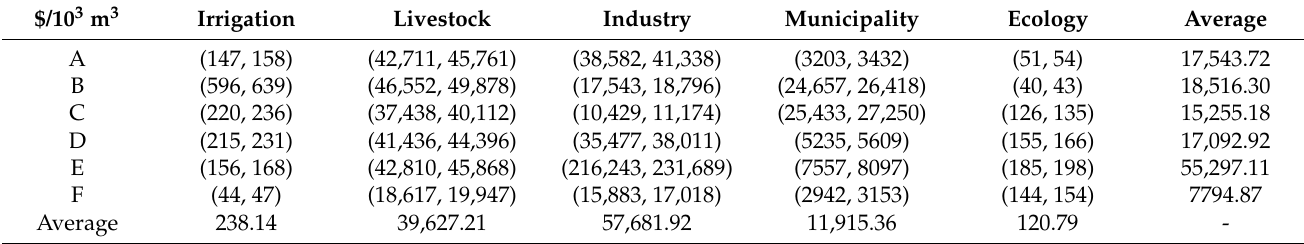
Table 8. The economic penalty